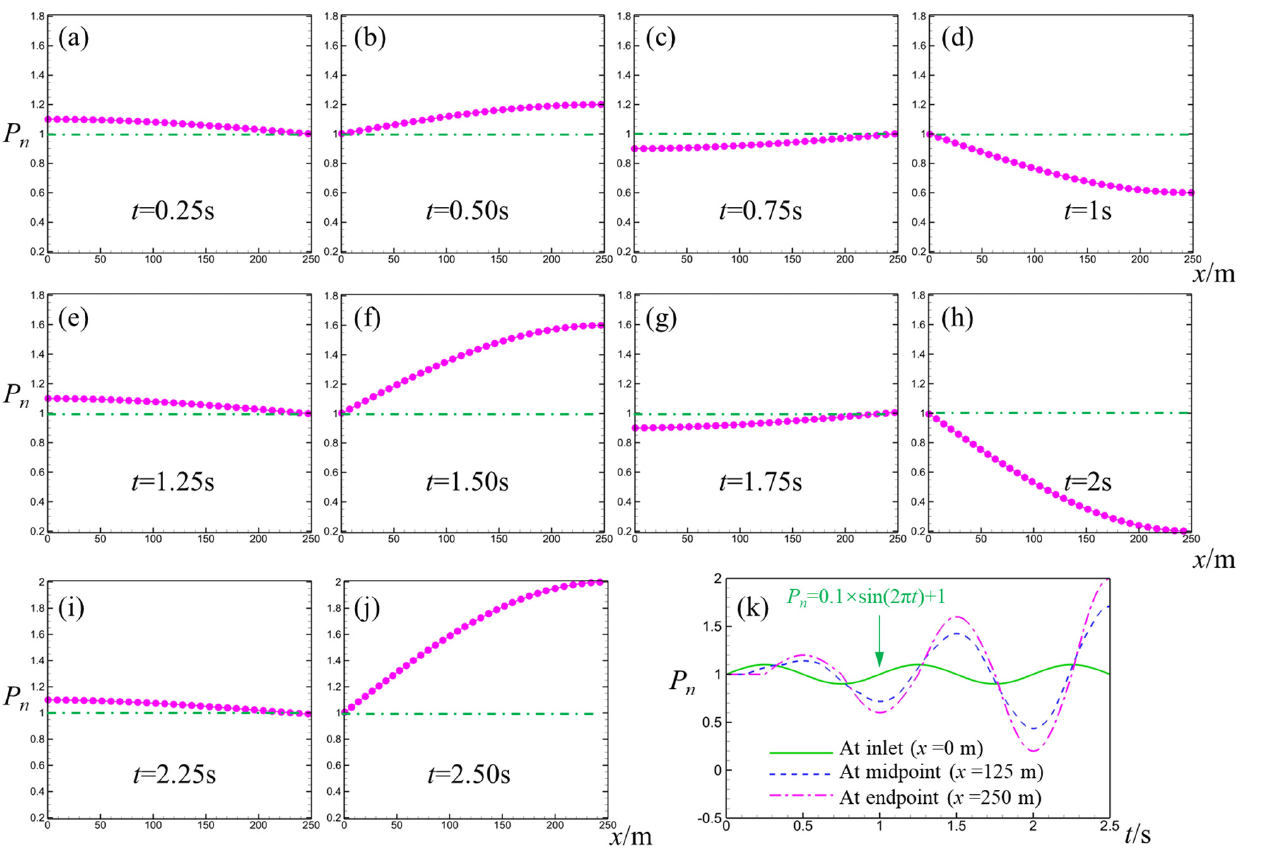
Figure 14. Normalized pressure–position curves during 2.5 pulse periods where L x = 250 m and f = 1 Hz. ( a–j ) t =0.25-2.5 s, ( k ) Normalized pressure–time curves during 2.5 pulse periods at inlet, midpoint and endpoint.